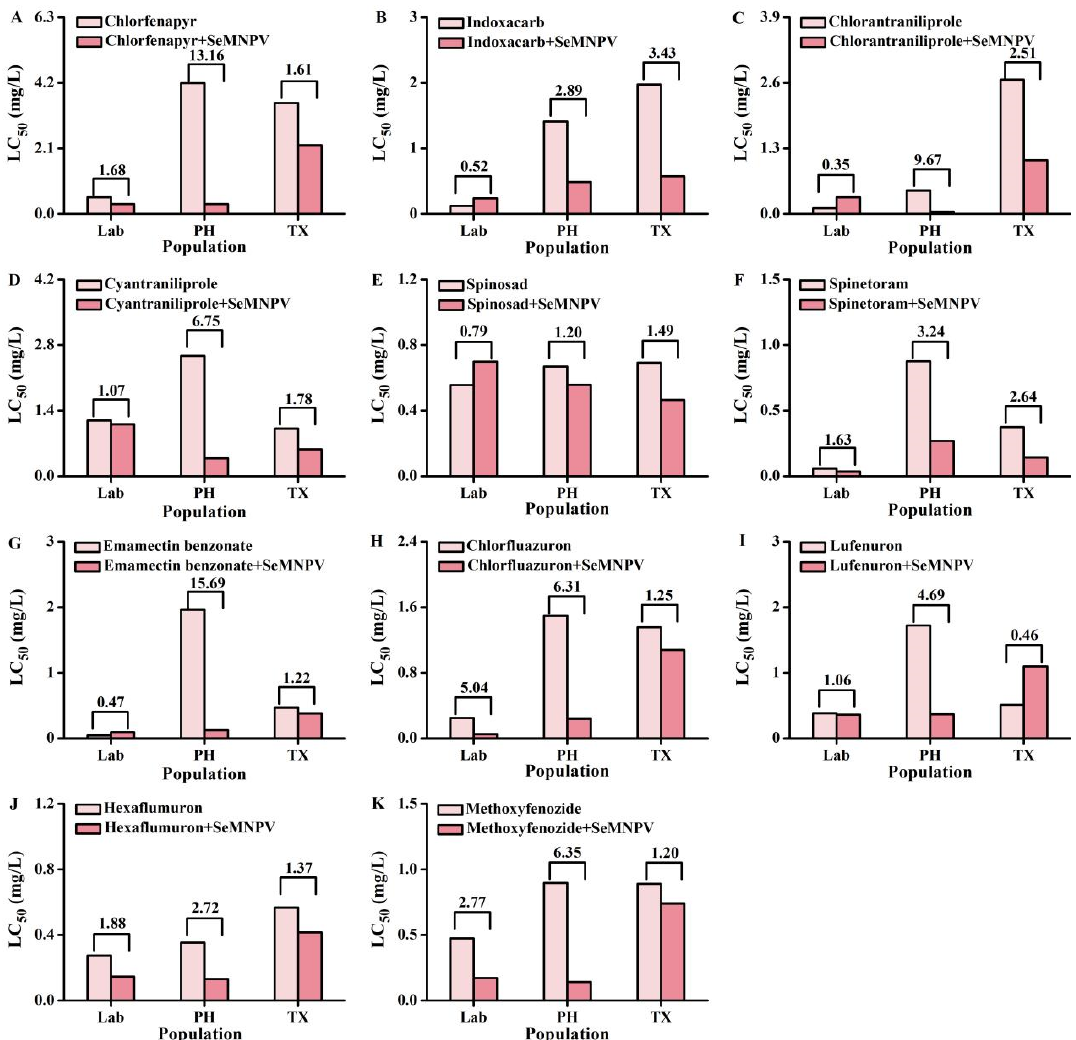
Figure 1. SeMNPV enhanced the toxicity of insecticides against S. exigua . LC 50 of chlorfenapyr ( A ), indoxacarb ( B ), chlorantraniliprole ( C ), cyantraniliprole ( D ), spinosad ( E ), spinetoram ( F ), emamectin benzonate ( G ), chlorfluazuron ( H ), lufenuron ( I ), hexaflumuron ( J ), methoxyfenozide ( K ) against three S. exigua population (Lab, PH and TX) with or without SeMNPV infection. The numbers in the above bars represent the ratio of enhanced toxicity. Table 5. Resistance of S. exigua against eleven insecticides combining with SeMNPV .